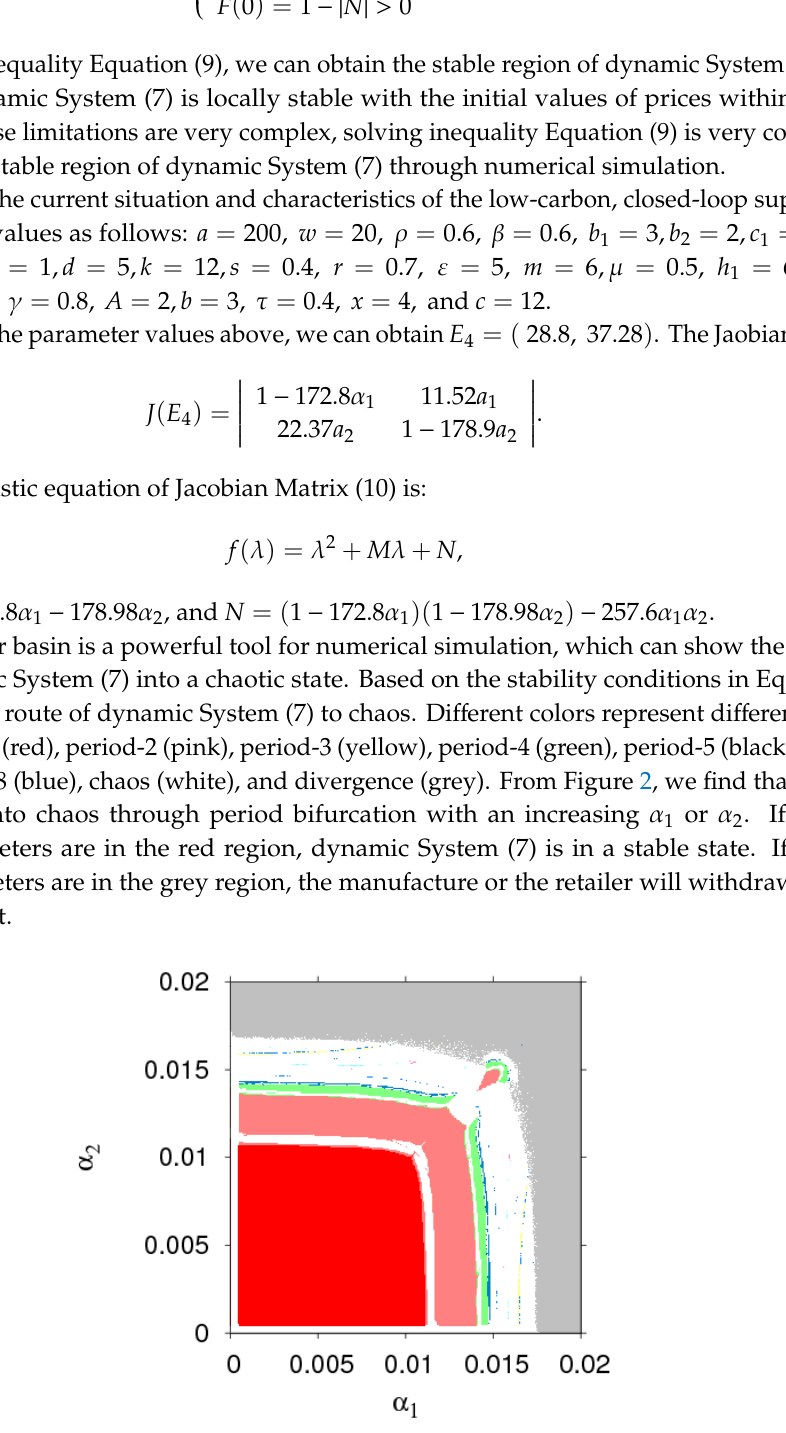
Figure 2 . The parameter basin of dynamic System (7) in the ( 𝛼 1 , 𝛼 2 ) plane. Figure 2. The parameter basin of dynamic System (7) in the (